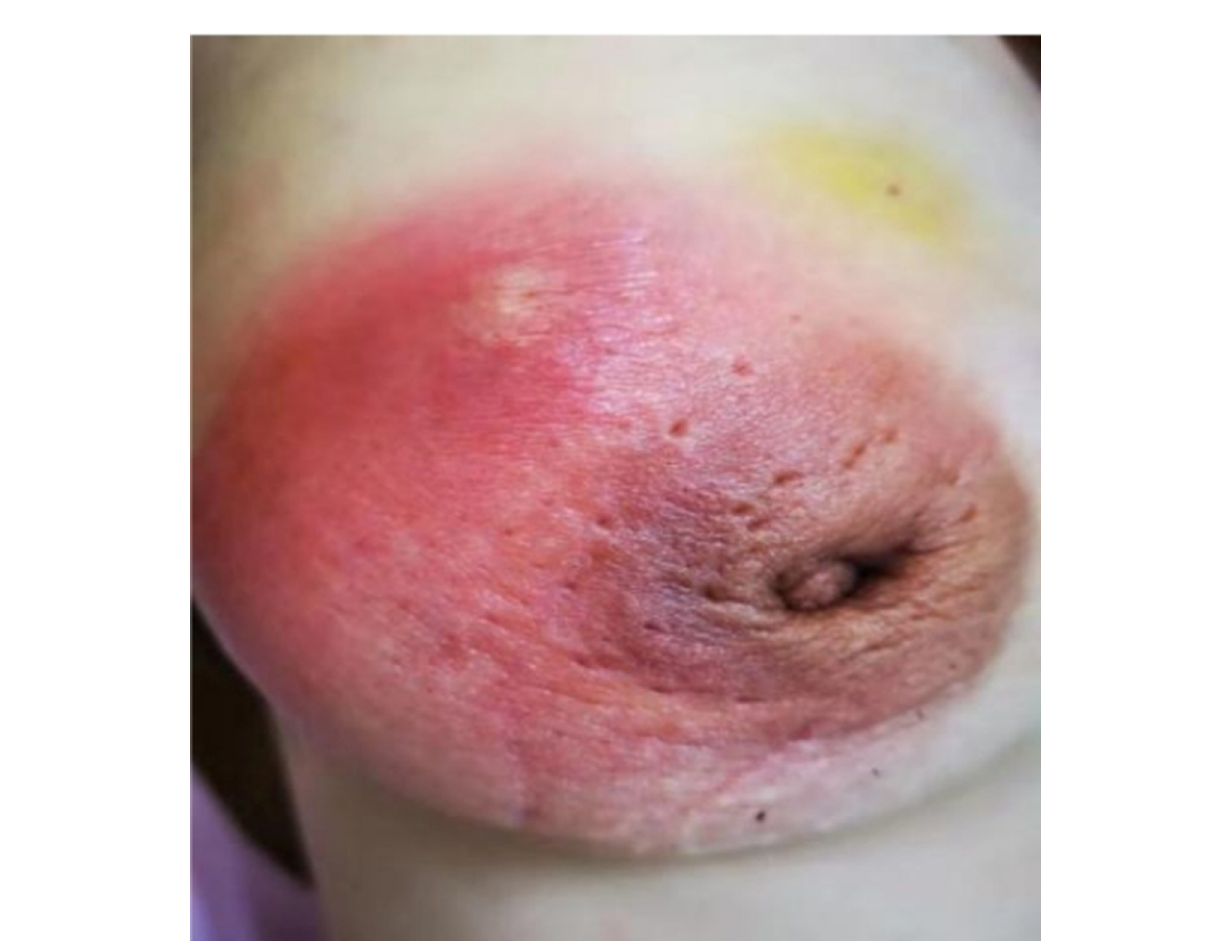
FIGURE8 Case 2. A lesion of a GM pus group patient photographed during her initial visit is seen. The diameter of the lump was ∼ 7cm, and red swelling was present around the areola, with abscess